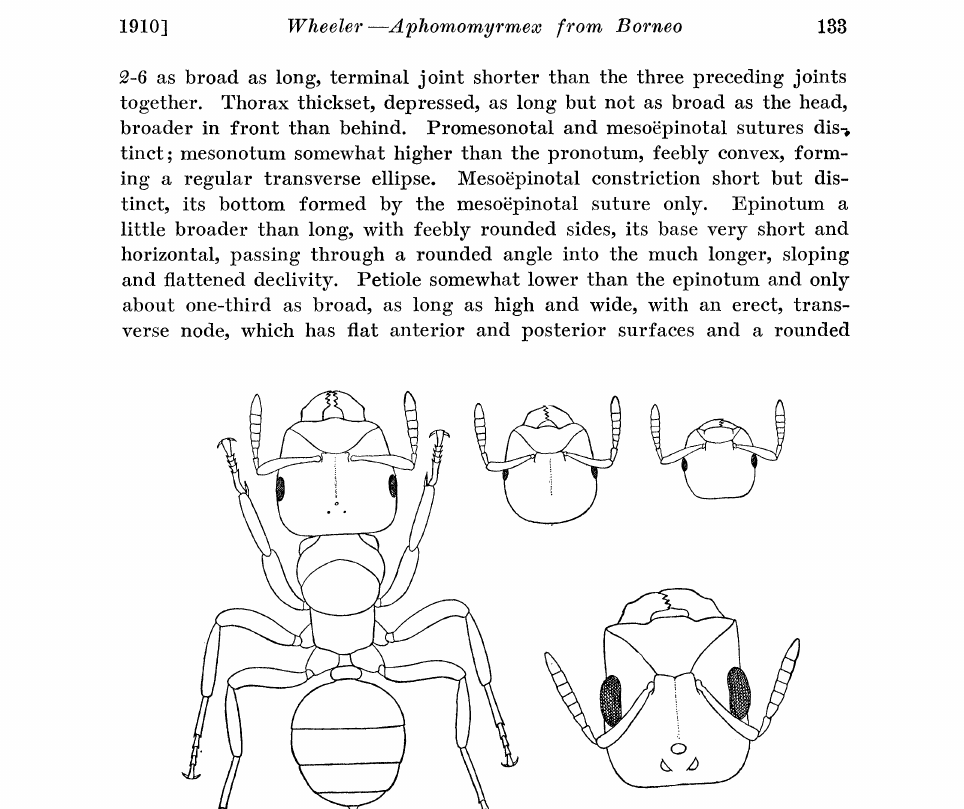
Fig. 1. Worker maxima of Aphomomyrmex hewitti sp. nov.; heads of worker media, worker minima and female, all drawn to the same" scale. upper surface. Gaster very broadly elliptical, smaller than the head, flat- tened dorsoventrally, with well-developed anal cilia. Legs long and robust; fore femora somewhat inerassated; claws and empodia large. Body shining. Mandibles, elypeus and cheeks subopaque, punetate and finely striate, except the middle of the elypeus, which is opaque and coarsely punetate. Head sparsely, thorax and gaster more densely punetate and less glabrous. Hairs yellowish, rather long and abundant, erect or subereet on all parts of the body and appendages, including the antennal funieuli. Pubescence yellowish, sparse and rather long, distinct on the thorax and gaster only in certain